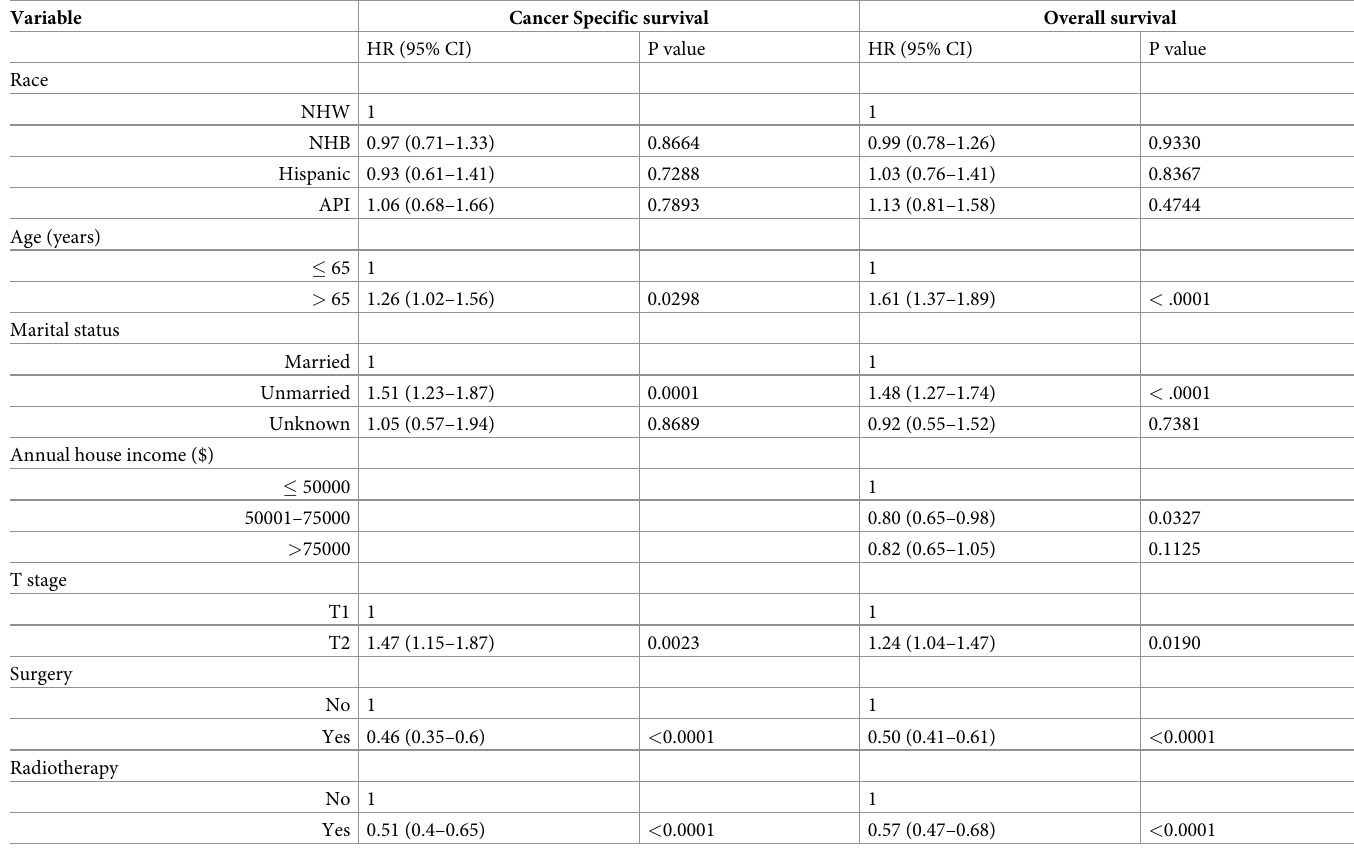
Table 6. Multivariate analysis of factors associated with survival in patients with early stage hypopharyngeal squamous cell